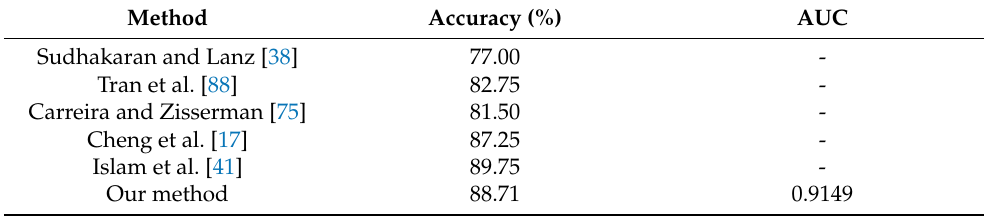
Table 3. Comparison of the proposed method and other previous methods on the RWF-2000